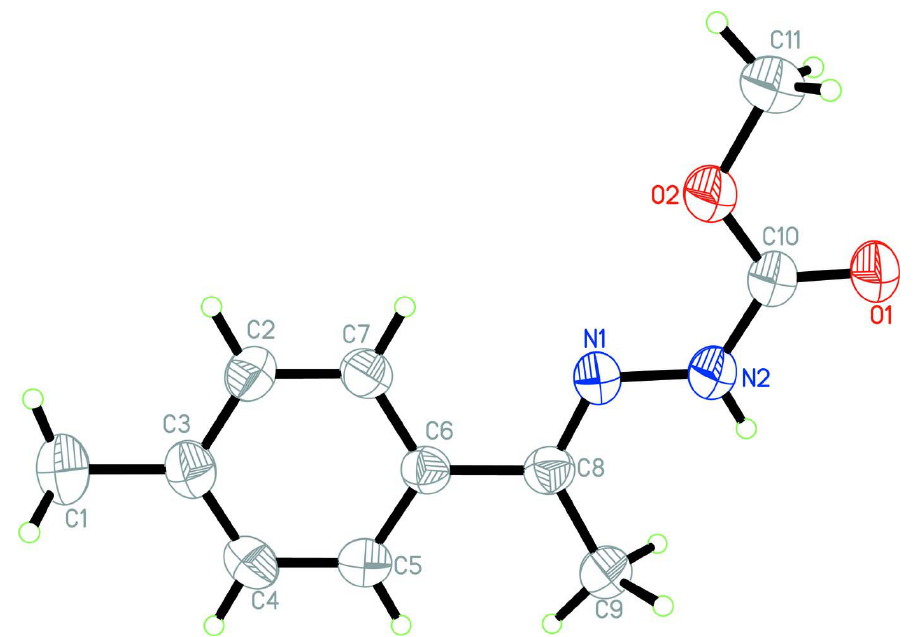
Figure 1 The molecular structure of the title compound, with the atom-numbering scheme. Displacement ellipsoids are drawn at the 40% probability